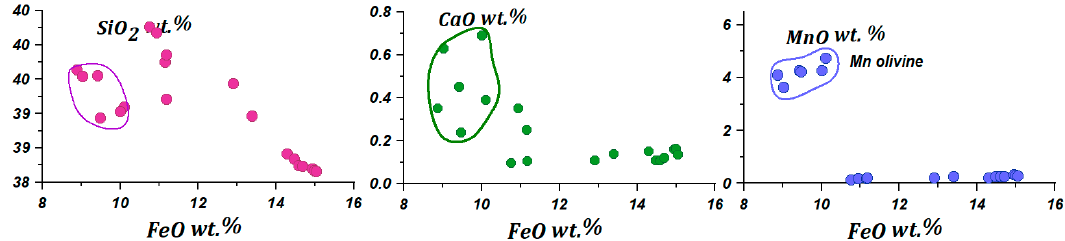
Figure 16. Variations of olivine compositions from BZM. The field of MnO is outlined.